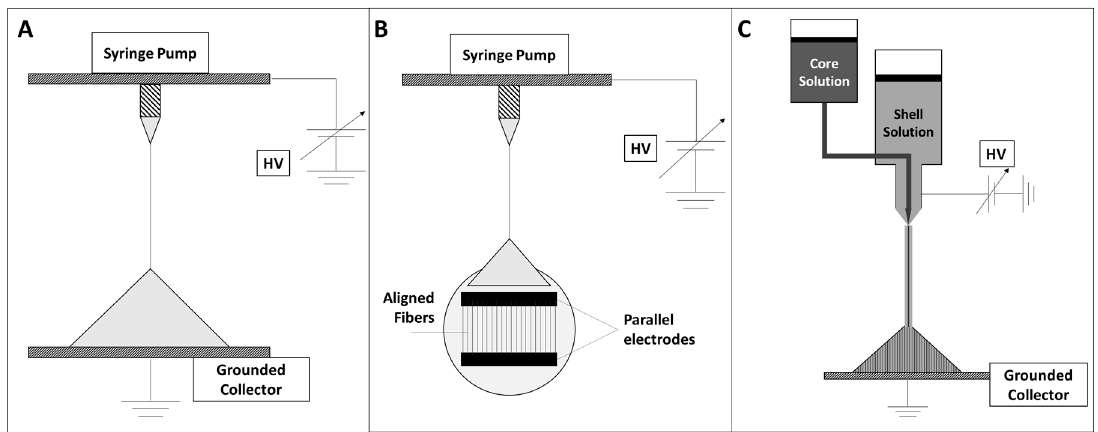
Figure 1. Schematic representations of ( A ) Conventional electrospinning setup; ( B ) parallel electrodes setup for aligned fibers; ( C ) coaxial electrospinning setup for core shell fibers.